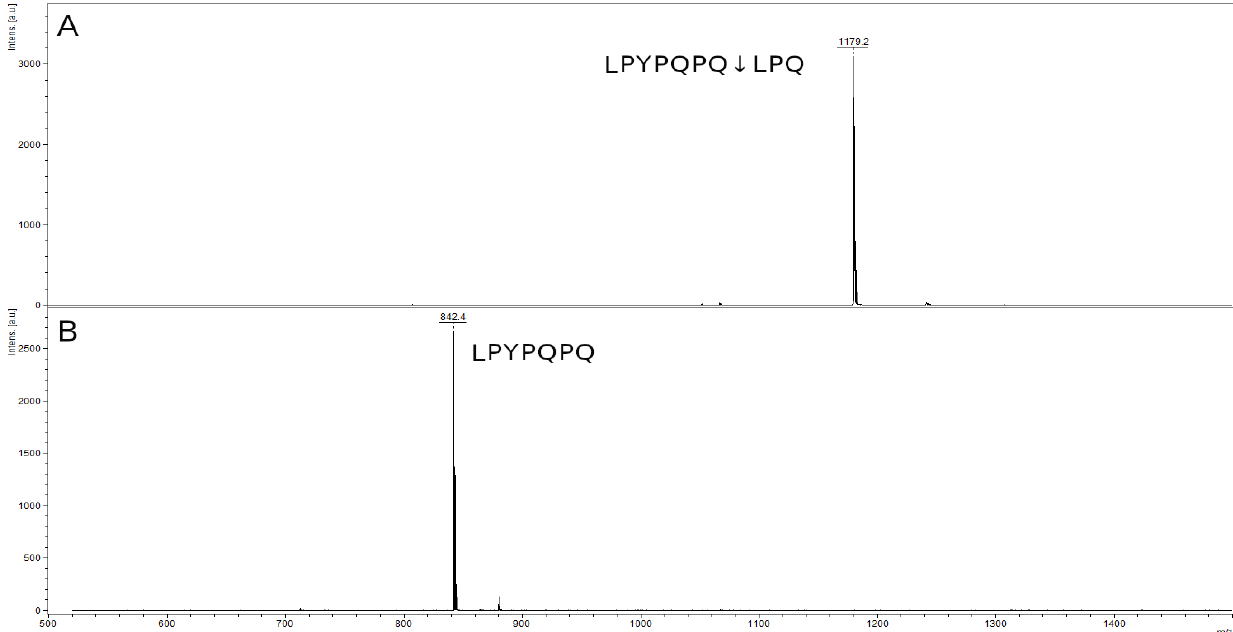
Table 1. Major products of the hydrolysis of the 33-mer peptide by rTcCathL1.